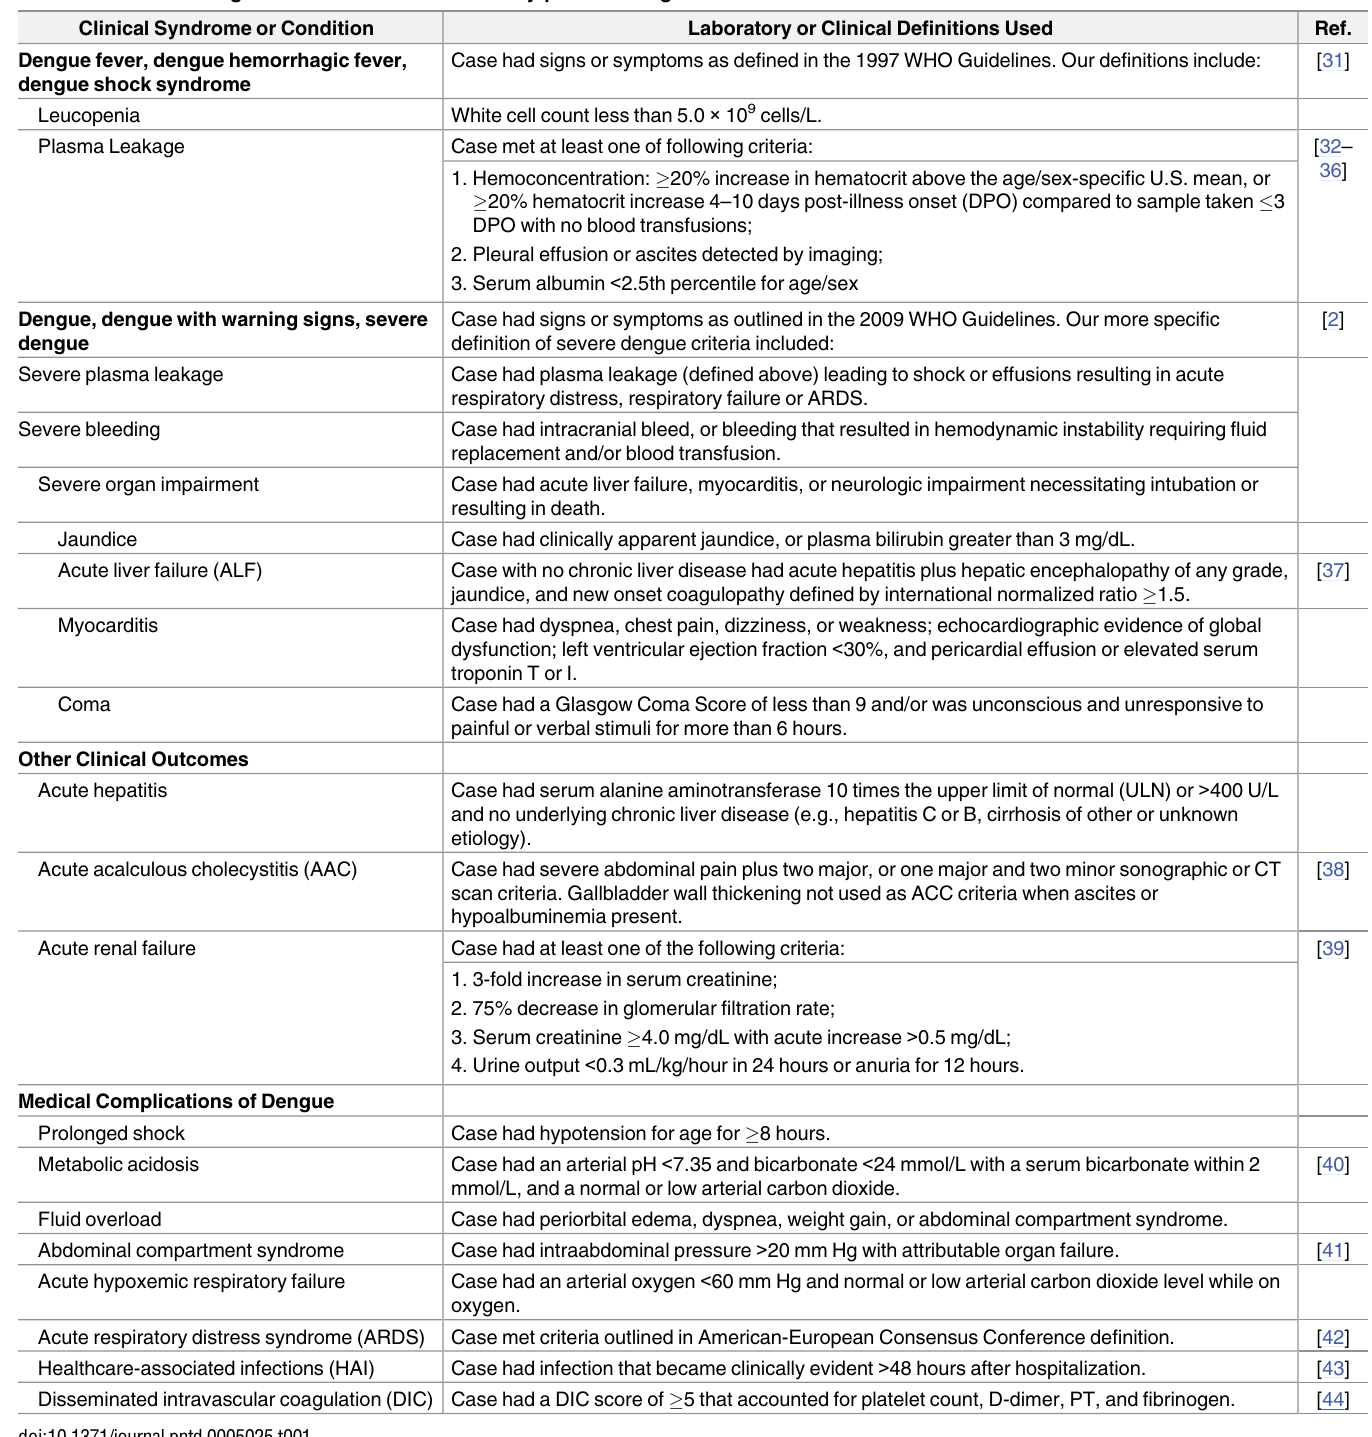
Table 1. Clinical findings used to define fatal laboratory-positive dengue